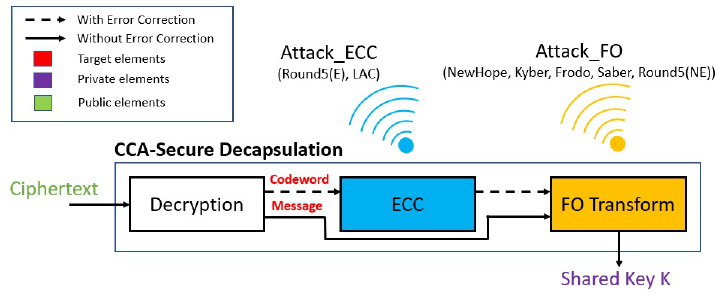
Figure 1: Pictorial representation of our proposed attacks on the IND-CCA secure decapsulation procedure